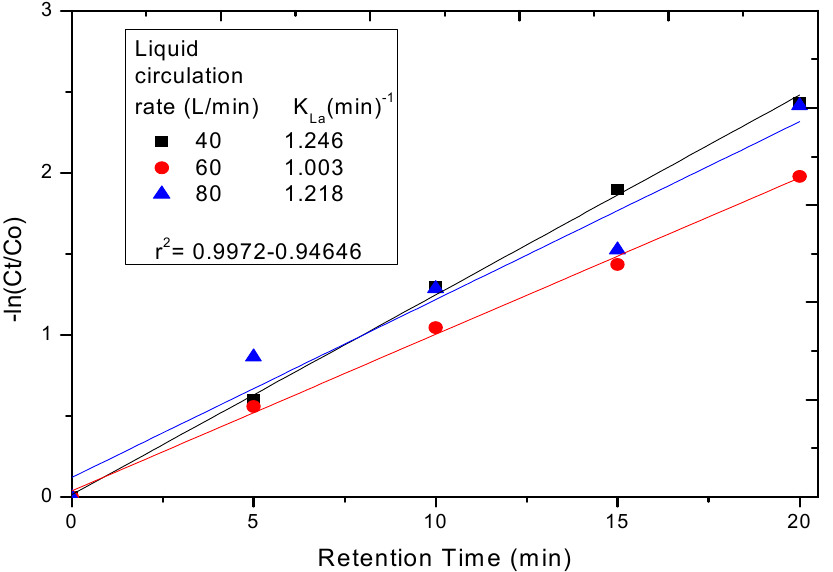
Figure 5. Effect of the liquid circulation rate on the K L a . (Initial HFC-134a conc.: 772 mg/L, air flow rate: 10 L/ min).